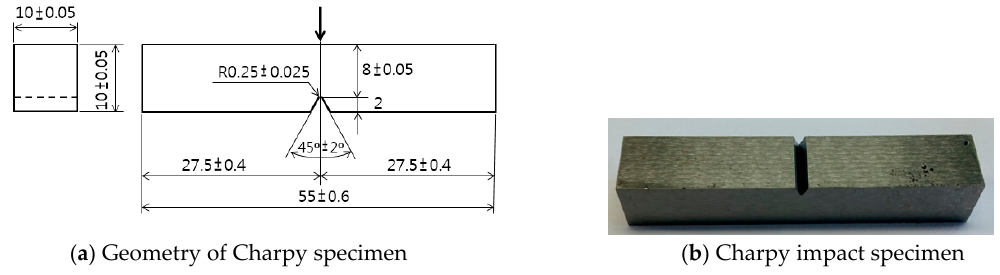
Figure 5. Geometry and photograph of the Charpy impact specimen.